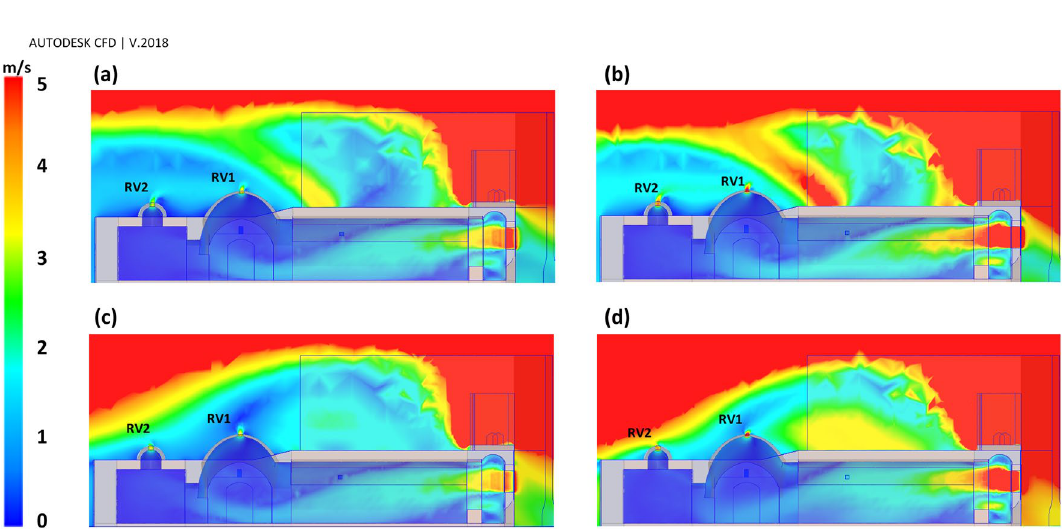
Figure 15. Flow pattern on the section A-A at different scenarios; ( a ) Sc17-10, ( b ) Sc17-15, ( c ) Sc30-10, and ( d )